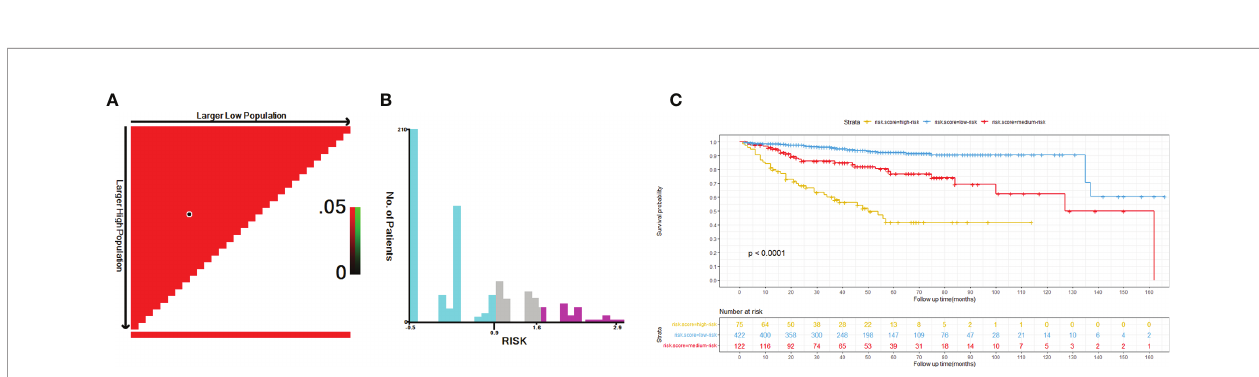
FIGURE 9 | Optimal cutoff values of risk score identi fi ed by X-tile analysis of patients with HIV-associated CTCL in the training cohort (A, B) . Overall survival of patients with HIV-associated CTCL strati fi ed by risk score (C) . HIV-associated CTCL, human immunode fi ciency virus associated cutaneous T-Cell lymphoma.